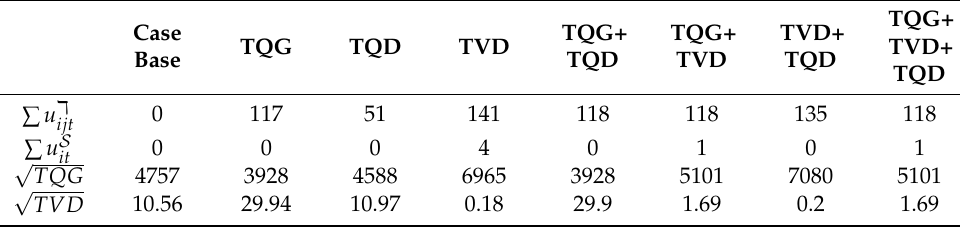
Table 3. Sensibility of the objective function components for the IEEE 57-bus system.